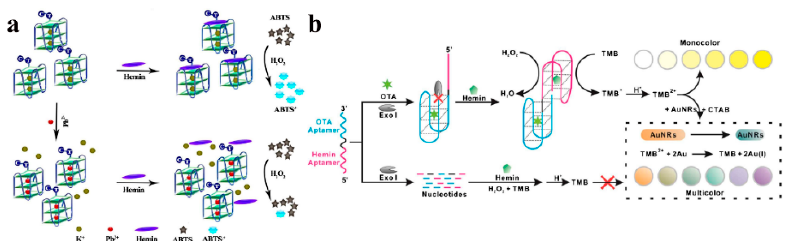
Figure 6. ( a ) Schematic diagram of G4 DNAzymes for Pb 2+ detection based on the competition between K + and Pb 2+ stabilized G4. Reprinted with permission from Ref. [90]. Copyright 2019 Springer; ( b ) Mechanism assay for OTA detection by exonuclease-assisted multicolor aptasensor. Reprinted with permission from Ref. [84]. Copyright 2018 Springer.